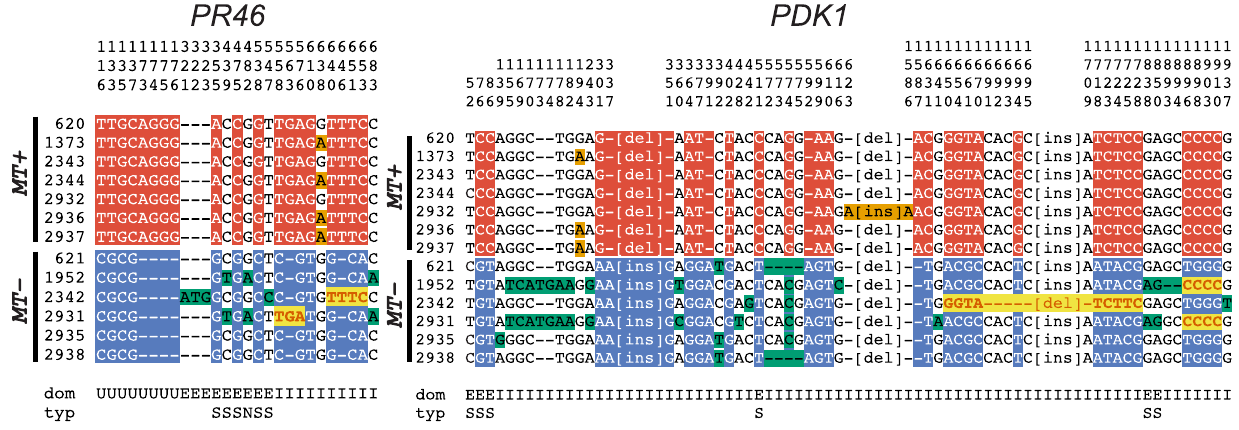
Figure 6. R-domain gene conversion between MT + and MT 2 haplotypes. Polymorphic positions in alignments of R-domain genes PR46 and PDK1 from 7 MT + and 6 MT 2 isolates described in Table S7. The position in the alignment is displayed vertically above each column reading downward. The domain (dom) of the gene in which the polymorphism occurs is indicated below each column as follows: E (exon), I (intron) and U (untranslated region). For exonic positions the type of substitution (typ) is indicated as synonymous (S) or non-synonymous (N). Small insertion/ deletion polymorphisms are indicated by dashes, while larger insertion/deletion polymorphisms are abbreviated as [ins] or [del]. Red background shading indicates polymorphisms specific to MT + isolates and blue background shading indicates polymorphisms specific to MT 2 isolates. Bold red sequences with yellow background shading show gene tracts where MT 2 sequences converted to MT + . Orange and green shading show polymorphisms segregating within MT + and MT 2 subgroups.